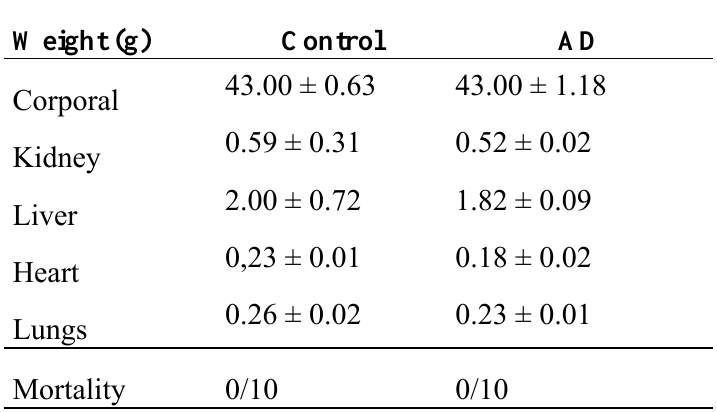
Table 1 . Evaluation of the acute toxicity of aqueous decoction (AD) of M. indica leaves (5 g/Kg, p.o.) in male Swiss mice